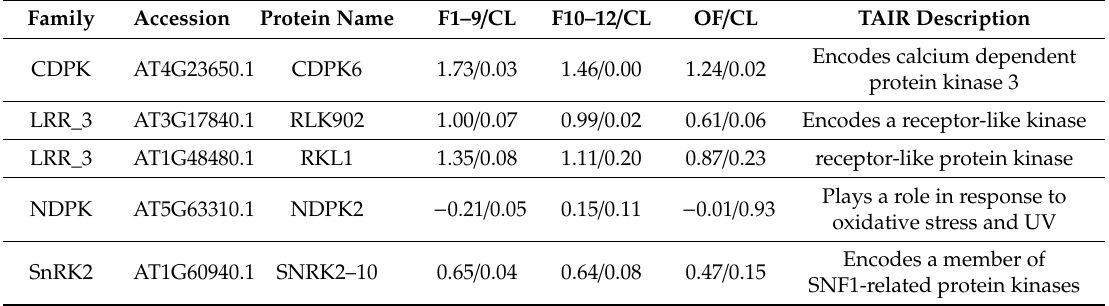
Table 2. Kinases and phosphatases that showed di ff erent expression levels in floral stages and cauline leaves.